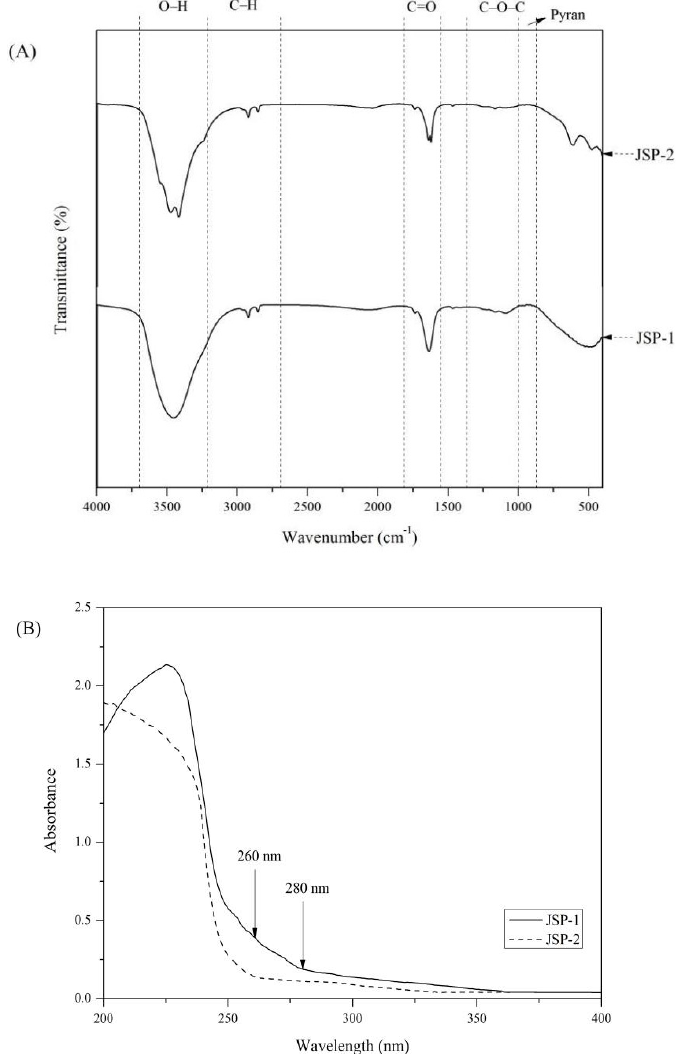
Figure 4. FTIR and UV analysis of JSP sub-fractions. ( A ) FTIR spectra of JSP-1 and JSP-2; ( B ) UV scan spectra of JSP-1 and JSP-2.